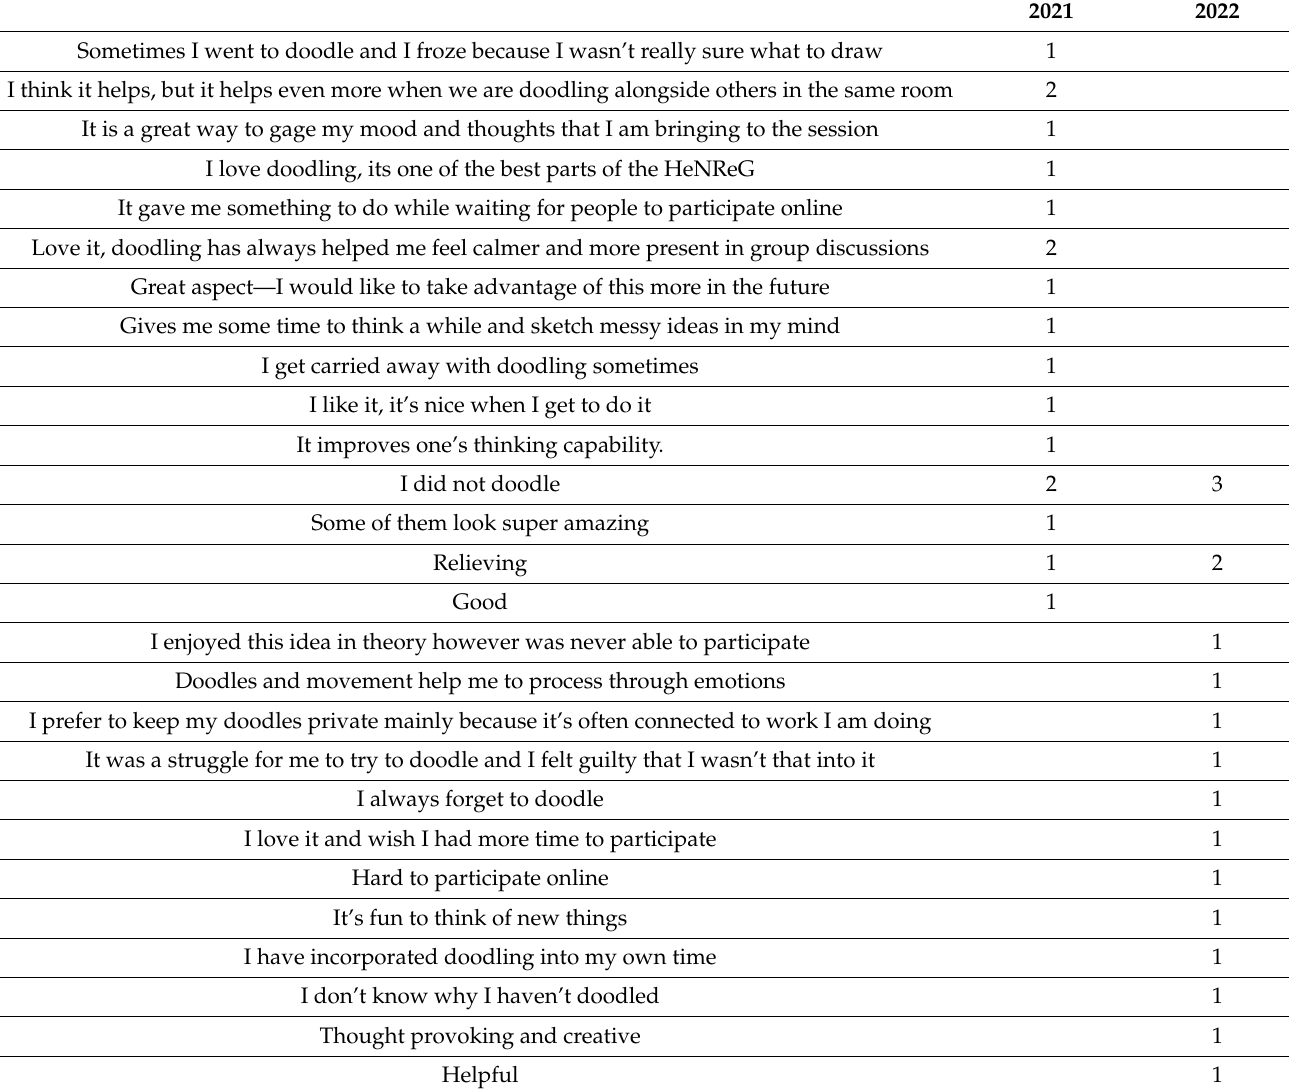
Table 6. Themes Mentioned in Responses Provided on the April Feedback Forms to “What Are Your Thoughts on Doodling Aspect of the HeNReG Experience?” the Two Most Recent Academic Years in Order of Receipt of Feedback Forms from Group